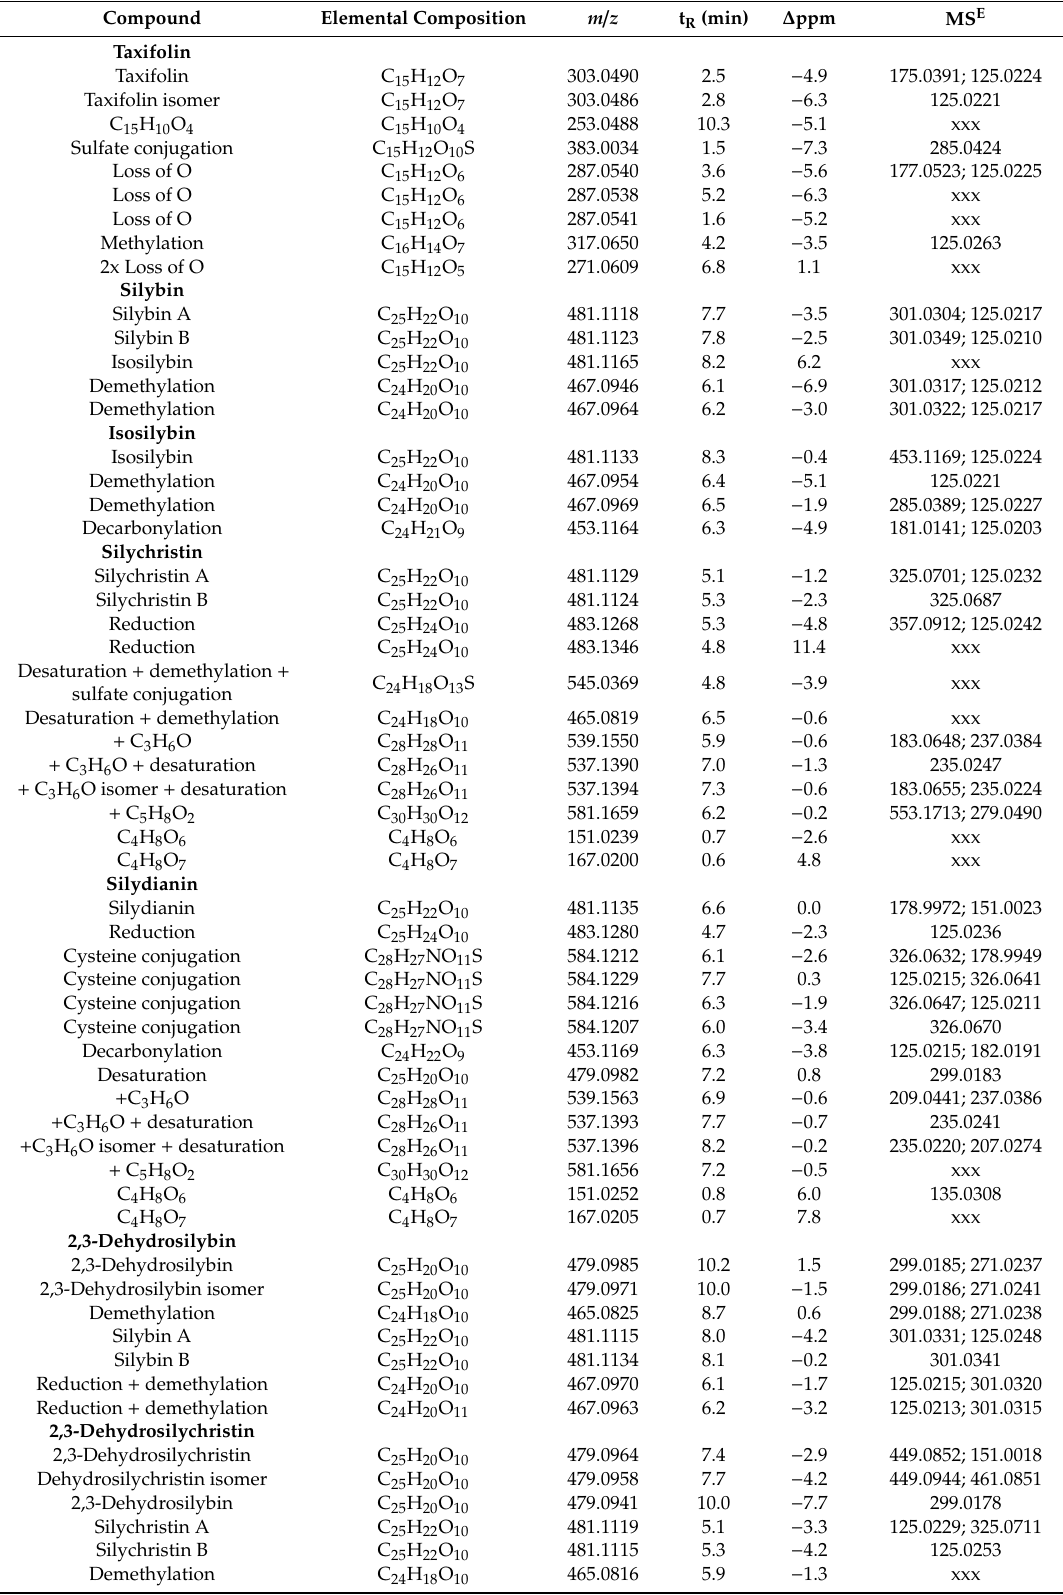
Table A1. LC / MS parameters of flavonolignans and their metabolites produced by human fecal